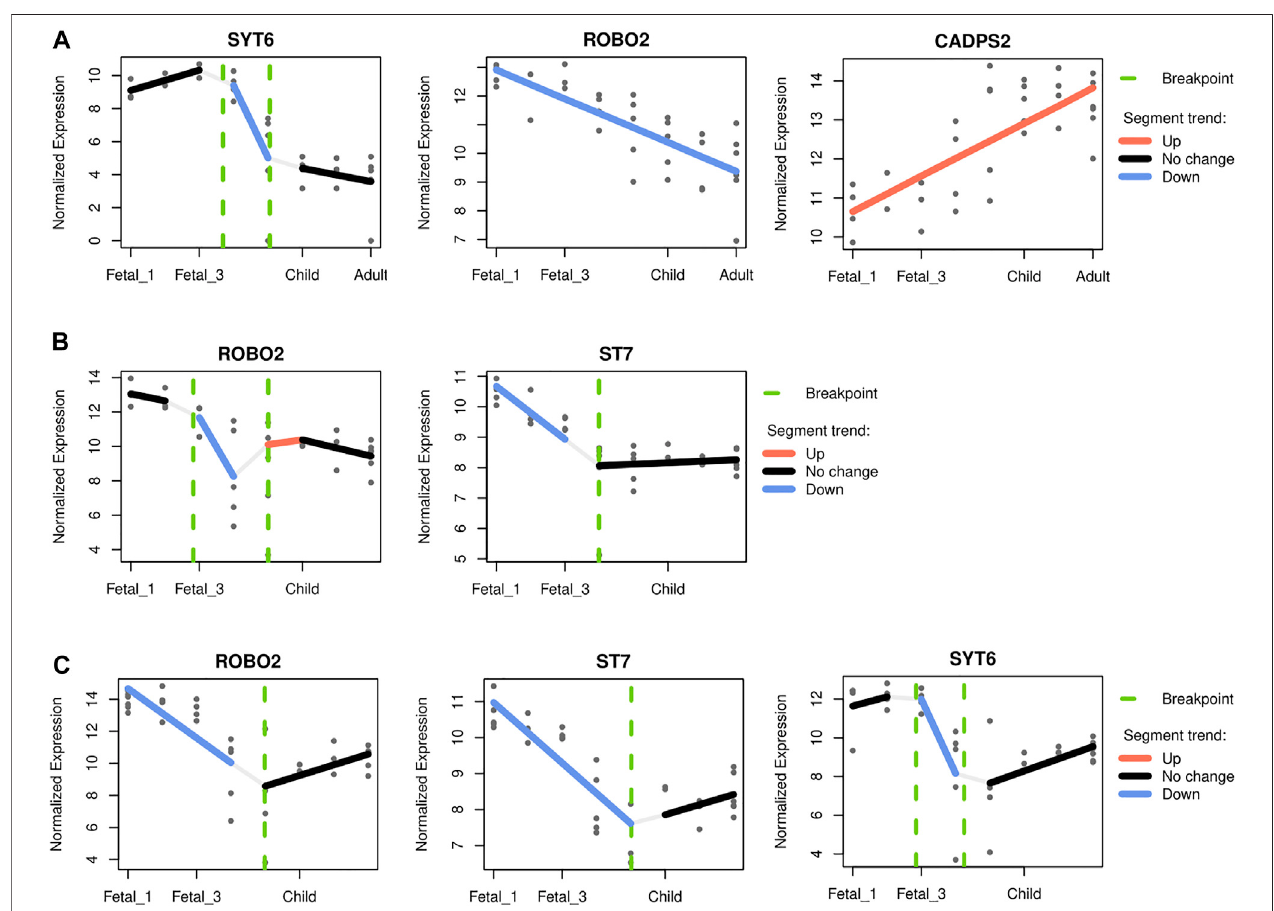
FIGURE 6 | Gene-speci fi c trajectories. A segmented regression analysis (Bacher et al., 2018) was performed to characterize the expression dynamics of genes under putative positive selection within introgression deserts, across developmental stages. Only genes with an adjusted R 2 above 0.5 were considered. (A) The cerebellum and the pro fi le of SYT6 , ROBO2 and CADPS2 . The pro fi le of CADPS2 was found to closely recapitulate the pattern observed for the cerellebum increasing from prenatal to postnatal stages (see Figure 3 ). (B) The mediodorsal nucleus of thalamus, and ROBO2 and ST7 , both genes with higher prenatal expression declining at around birth. (C) The striatum and ROBO2 , ST7 and SYT6 . The three genes follow a similar expression dynamics peaking at early fetal stages but declining afterwards, and increasing again postnatally.